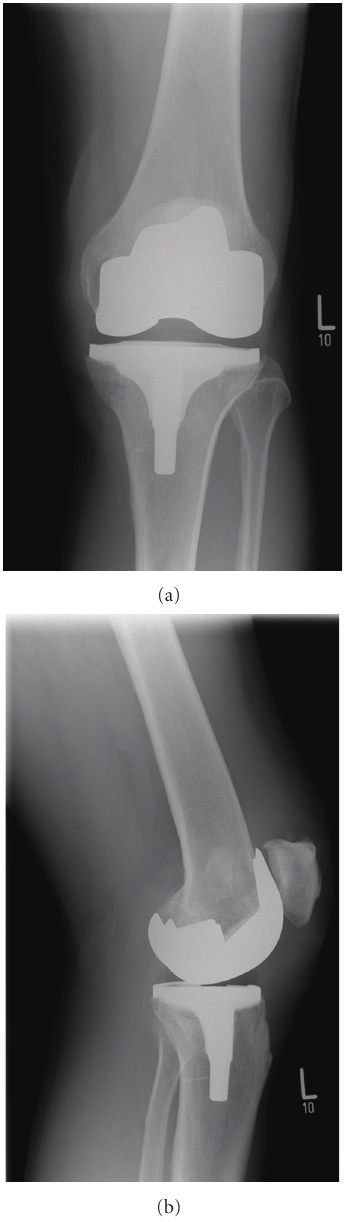
Figure 1: (a, b) Postoperative AP and lateral weight-bearing radio- graphs showing satisfactory alignment of the prosthesis.